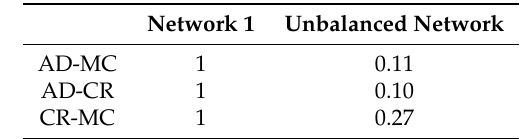
Figure 8. The similarity (ARI) varies with the increasing iteration times between the classification results of the MDND and the administrative divisions. It can be seen that the increase of ARI value with the increase of the iteration times is obvious, and the volatility is very large. Table 5. Comparison of the analysis results of the MDND on the sparse network with the administrative divisions and community detection